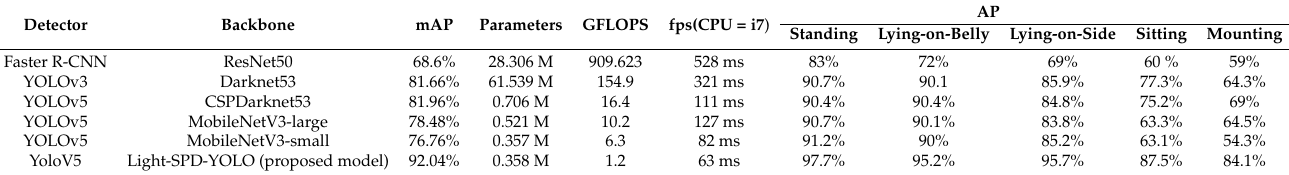
Table 3. Performance comparison of different